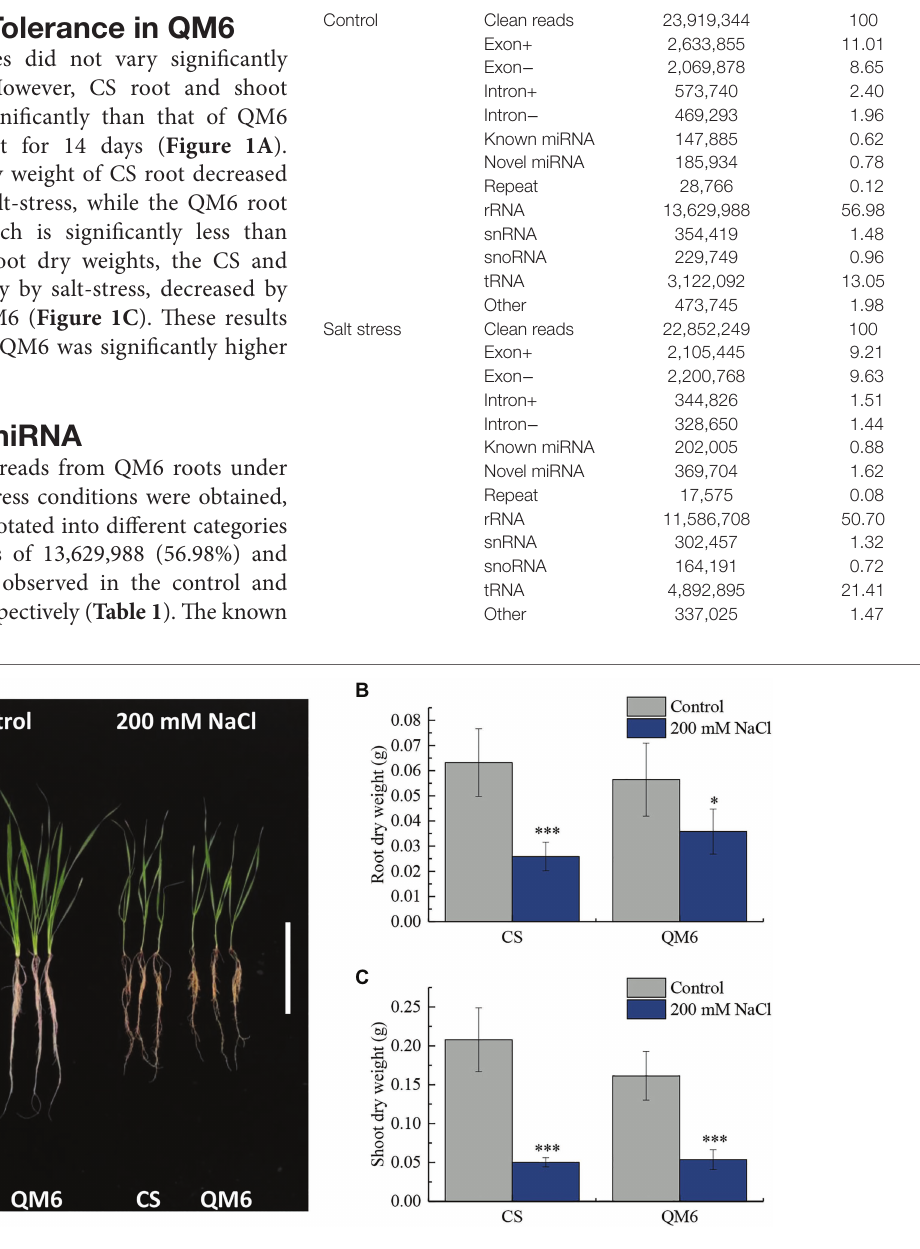
FIGURE 1 | The Chinese Spring (CS) and Qing Mai 6 (QM6) phenotype under 200 mM NaCl-induced salt stress and control conditions. (A) The phenotypic difference of CS and QM6 in response to salt stress; bar = 5 cm. (B) The CS and QM6 root dry weights under 200 mM NaCl-induced salt stress and control conditions. (C) The CS and QM6 shoot dry weights under 200 mM NaCl-induced salt stress and control conditions. n = 3; * p < 0.05; *** p <